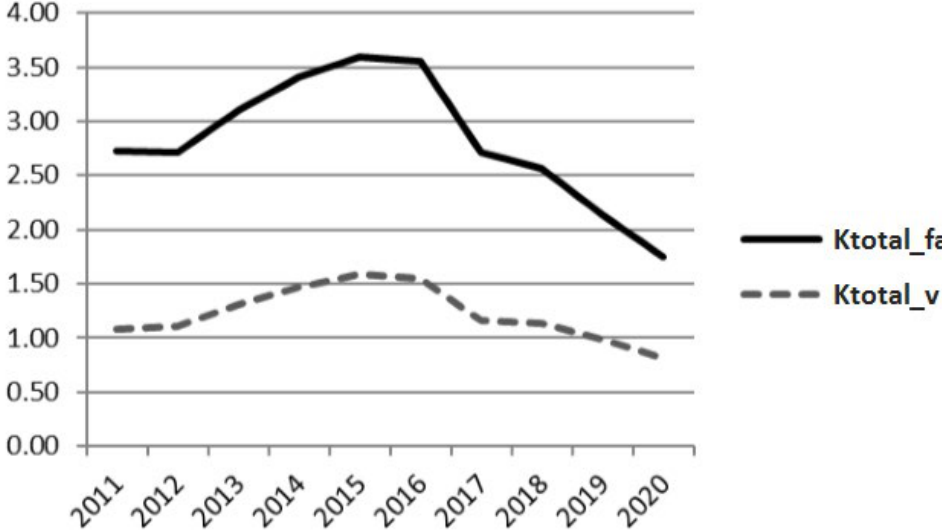
Figure 8. Ktotal value dynamics for the PJSC “Norilsk Nickel”. Ktotal_fa—Ktotal for the total fixed assets; Ktotal_v—Ktotal for the total cost of machinery and equipment. Ktotal_fa and Ktotal _v were calculated based on the initial fixed assets, intangible assets, and R&D costs.